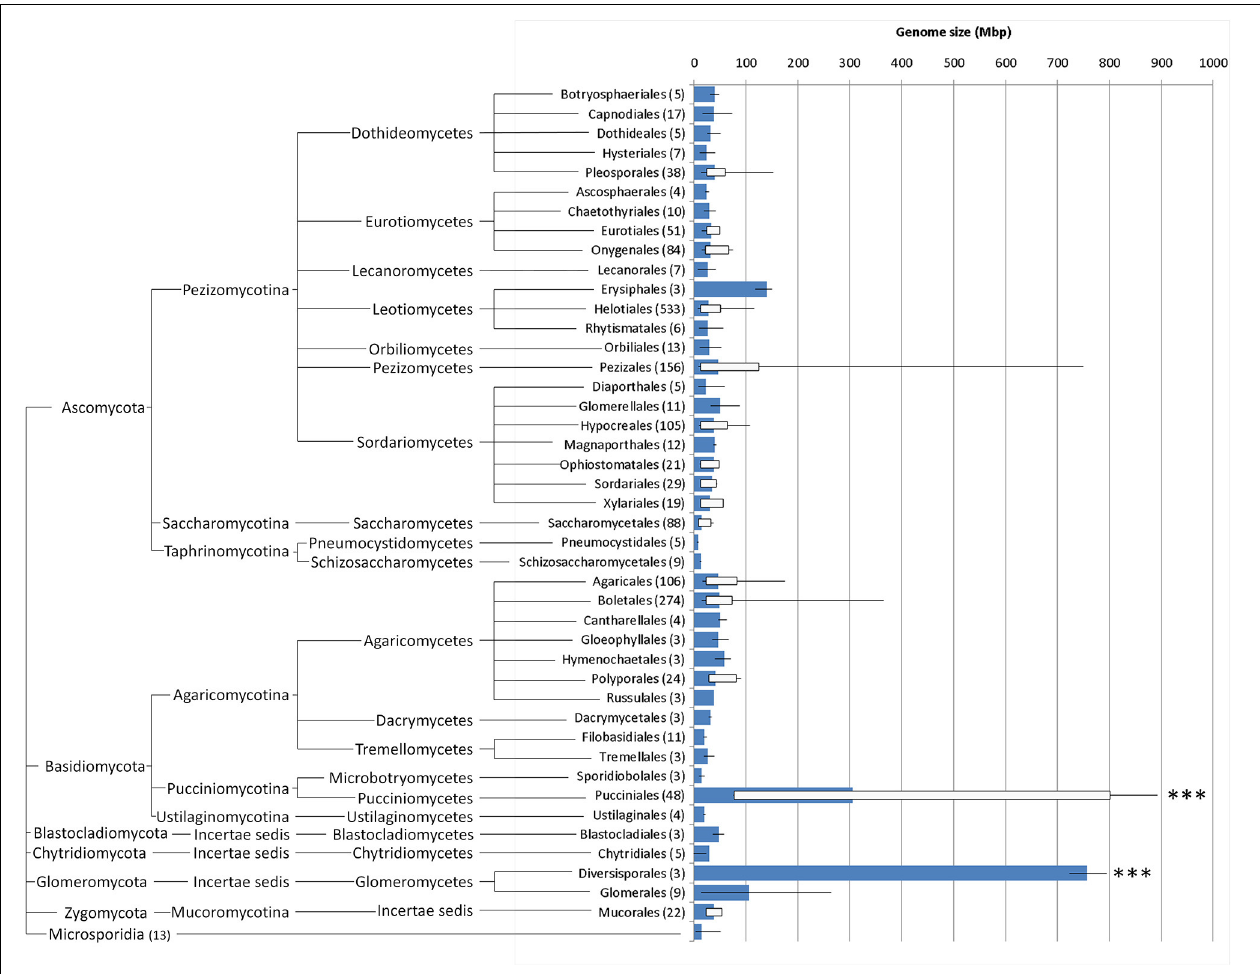
FIGURE 4 | Whisker box plots for genome sizes (Mbp) for every fungal order for which at least three values were available (number of organisms in brackets; further details in Supplementary Data, database sheet), including the results obtained in this study; blue